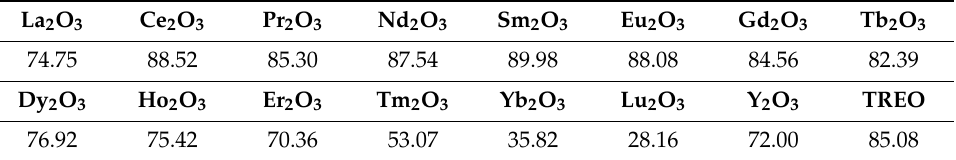
Table 11. The precipitation rates of REO from the concentrate into the PG (%).